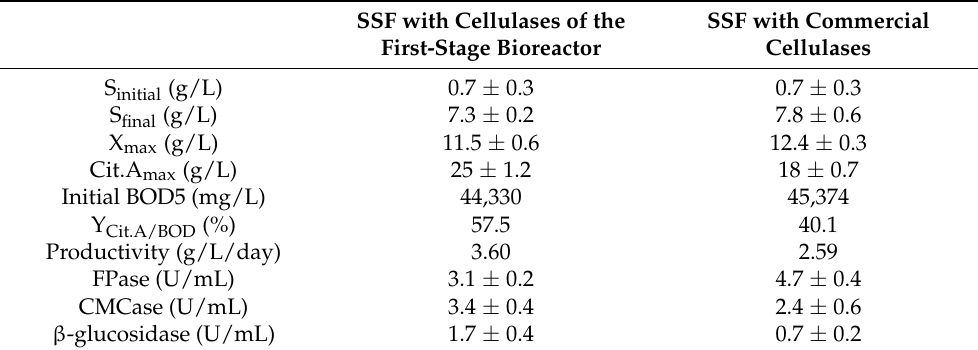
Table 3. Effect of cellulase enzyme source on the simultaneous saccharification and fermentation (SSF) of OMW for the production of citric acid in a two-stage process running continuously using loofa sponge-packed